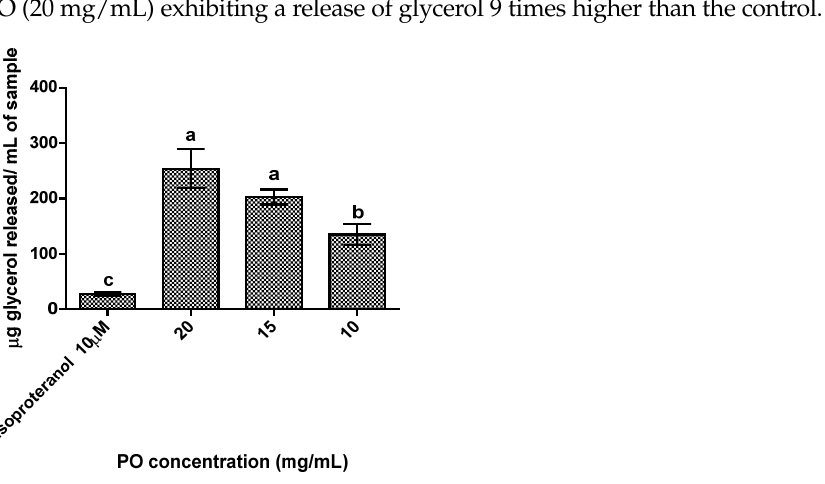
Figure 2. Adipolysis results for the different pomegranate oil concentrations tested. Isoproteranol at 10 µM was used as a positive control. Different letters represent significant differences as determined by the one-way ANOVA test ( p < 0.05).